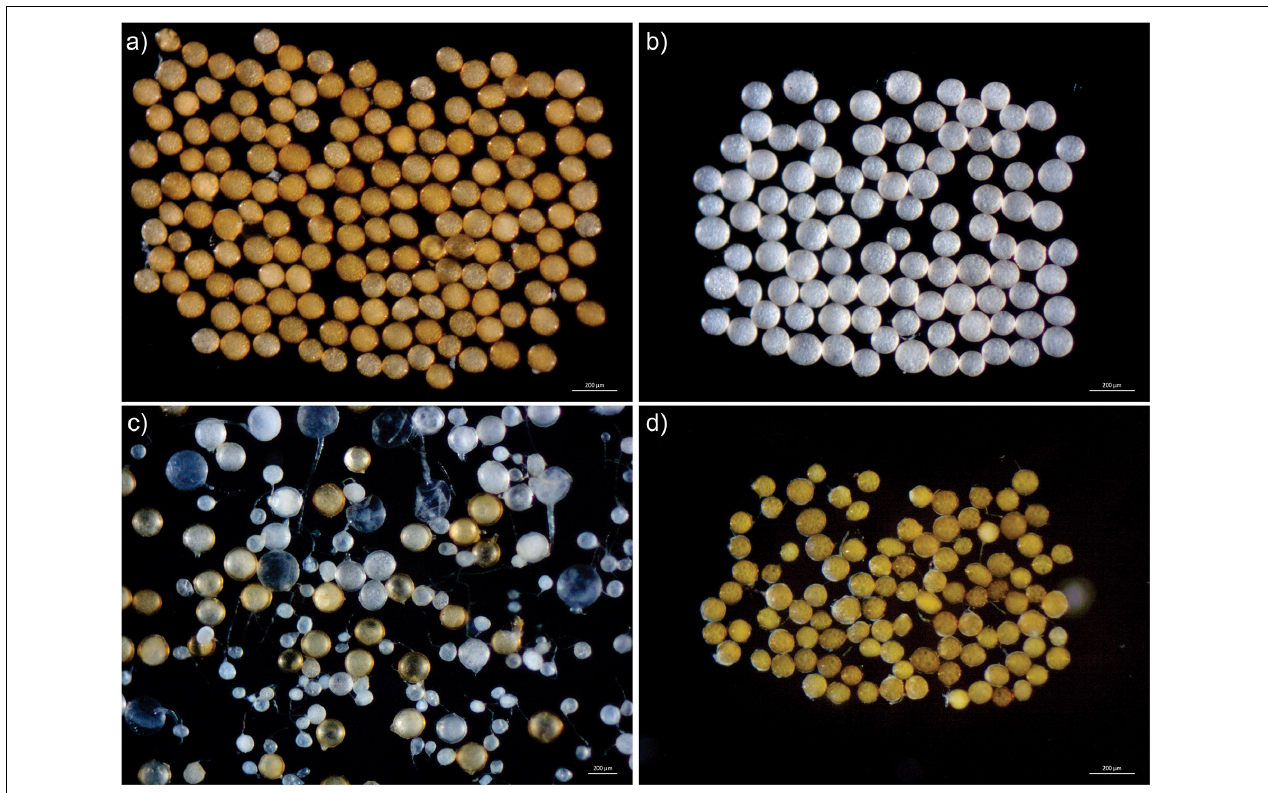
FIGURE 1 | Spores of the most frequent species of Glomeromycota in the Neotropics: (a) Acaulospora mellea , (b) Acaulospora scrobiculata , (c) Ambispora leptoticha , (d) Claroideoglomus etunicatum . Source: International Culture Collection of Glomeromycota (www.furb.br/cicg).